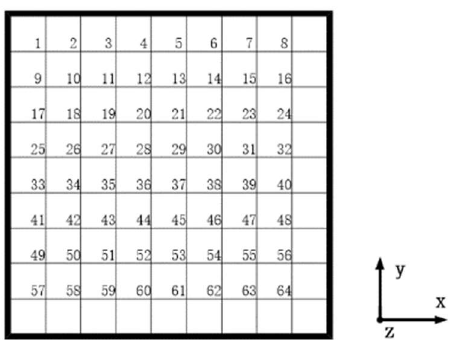
Figure 1. Division diagram with 9 × 9 grid size.